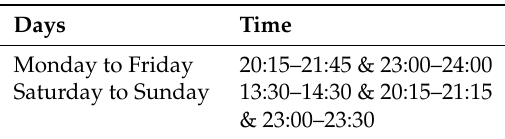
Table 2. Electric heating